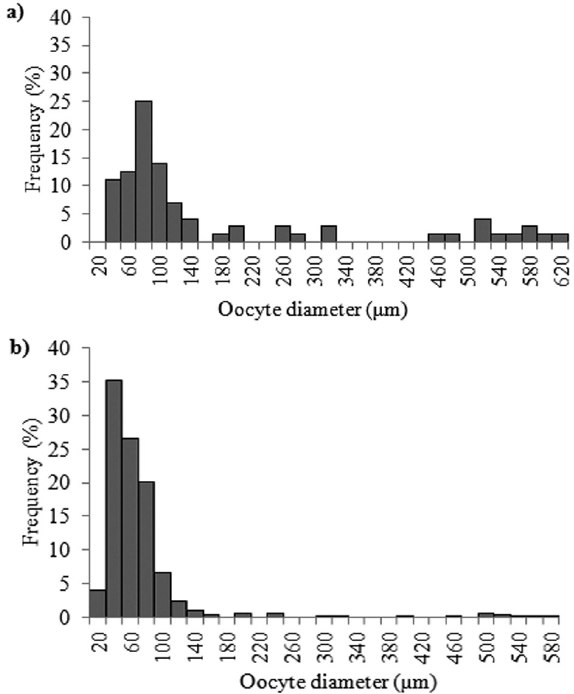
f ig . 7. – Size-frequency distribution of oocyte diameters grouped per 20 µm from histological sections of 2 meagre females. a) 166 cm L female captured in April at ripening stage. b) 108 cm L female captured in August at final spawning stage.